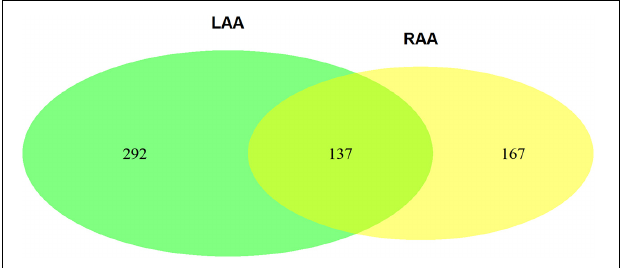
FIGURE 5 | The Venn plot constructed by two AF-associated modules in LAA and three AF-associated modules in RAA (GS > 2). GS, gene significance; LAA, left atrial appendage; RAA, right atrial